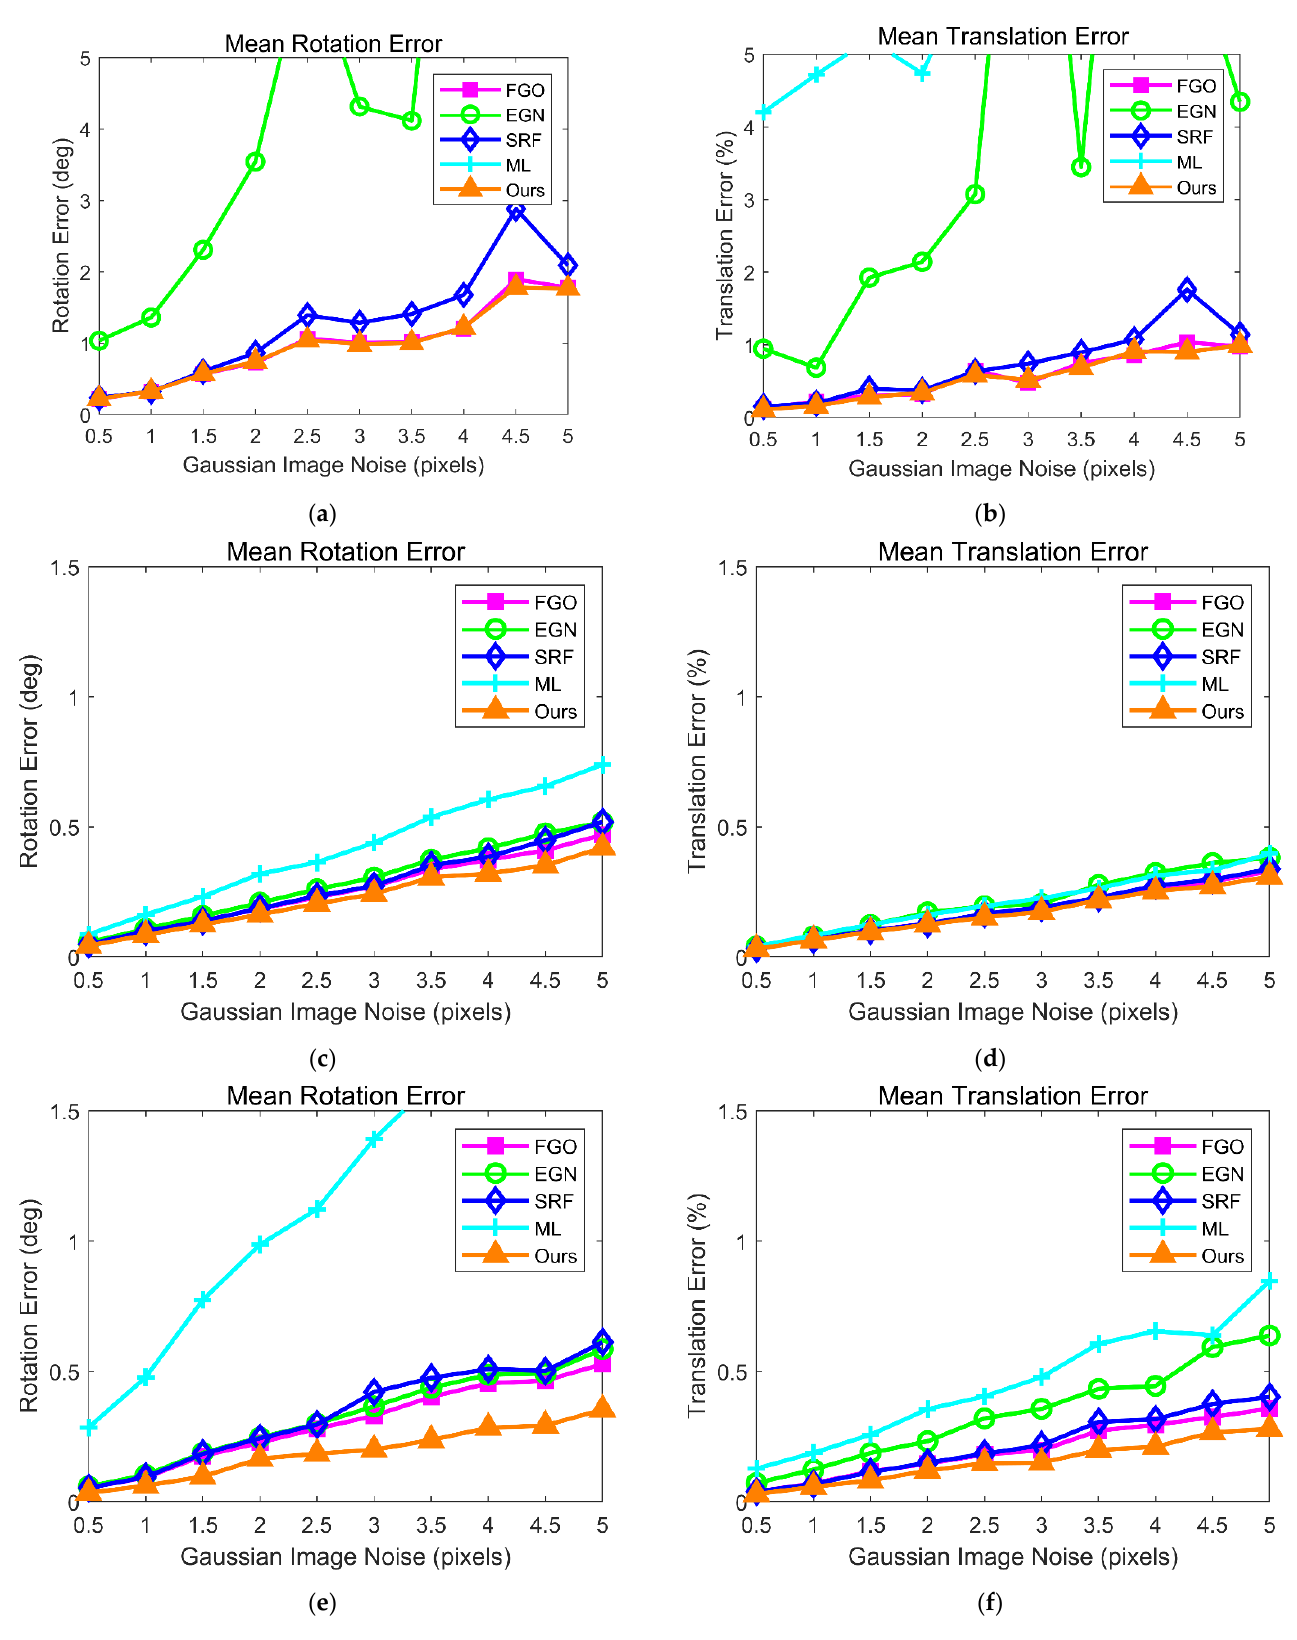
Figure 5. The accuracies of pose determinations with respect to the Gaussian image noise. ( a , b ) are in the planar configuration; ( c , d ) are in the ordinary configuration; and ( e , f ) are in the quasi-singular configuration, respectively.